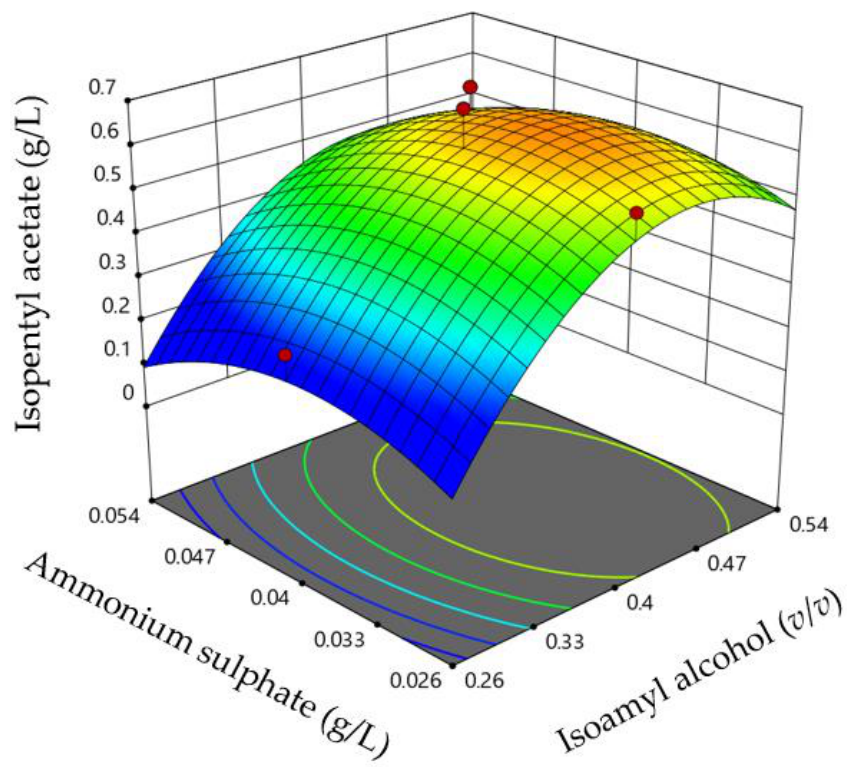
Figure 2. The response surface plots showing the effects of independent variables on the r p .